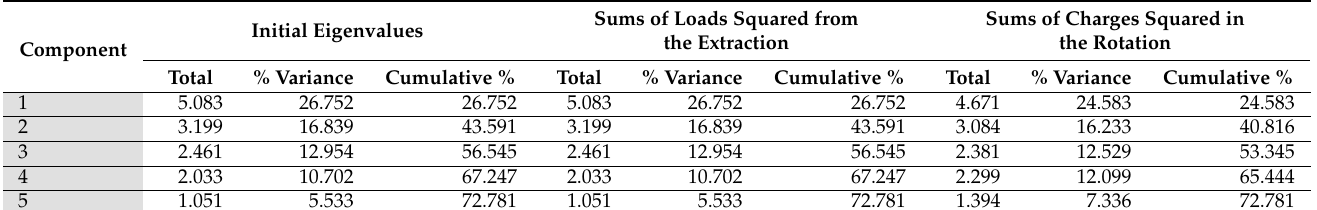
Table 6. Total variance